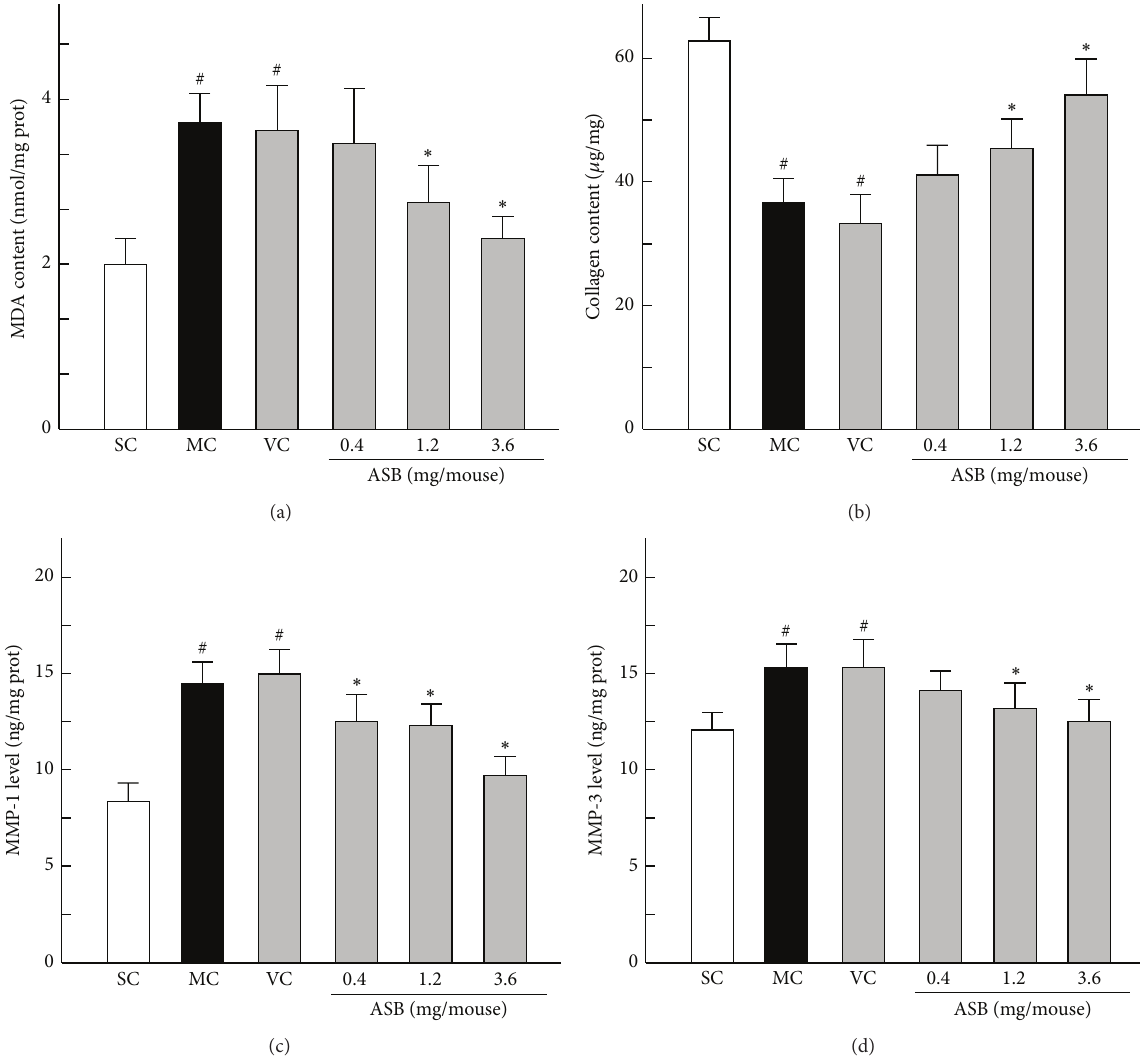
Figure 5: Effect of andrographolide sodium bisulfate (ASB) on the level of malondialdehyde (MDA) and collagen content and the expression of matrix metalloproteinase-1 (MMP-1) and MMP-3 in photoaged mice skin. Data represents means ± SD ( 𝑛 = 8 ). # 𝑝 < 0.05 compared with the SC group; ∗ 𝑝 < 0.05 compared with the VC group. NC, normal control; SC, sham control; MC, model control; VC, vehicle